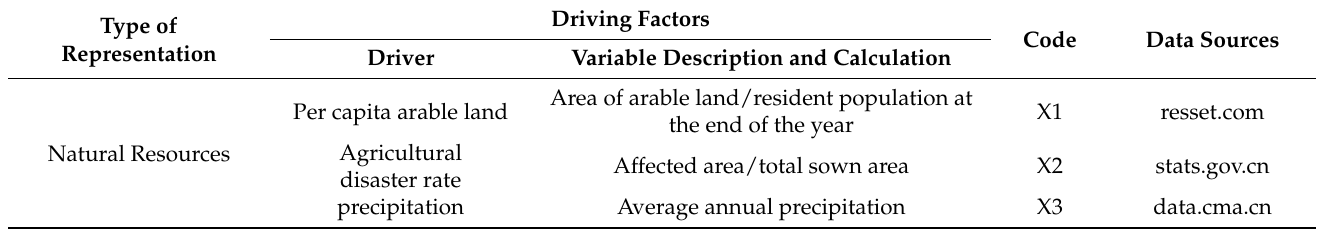
Table 2. Driving factors and classification of